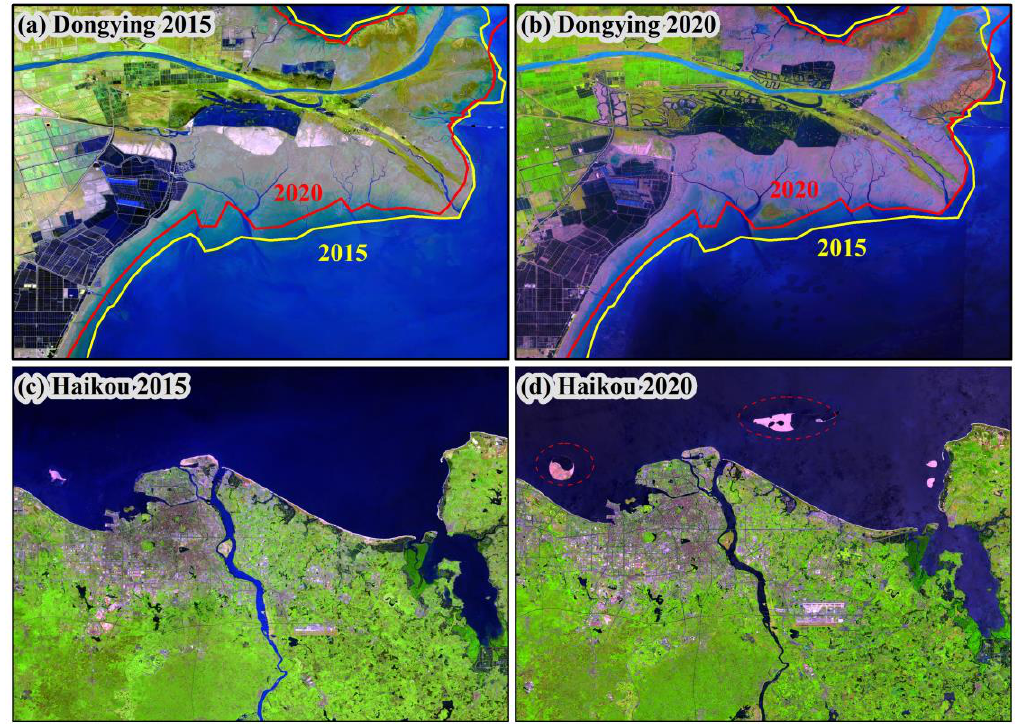
Figure 12. Remote sensing images in the coastal area of Dongying and Haikou. The yellow and red solid lines indicate the coastal beach areas of Dongying coastal region in 2015 and 2020,